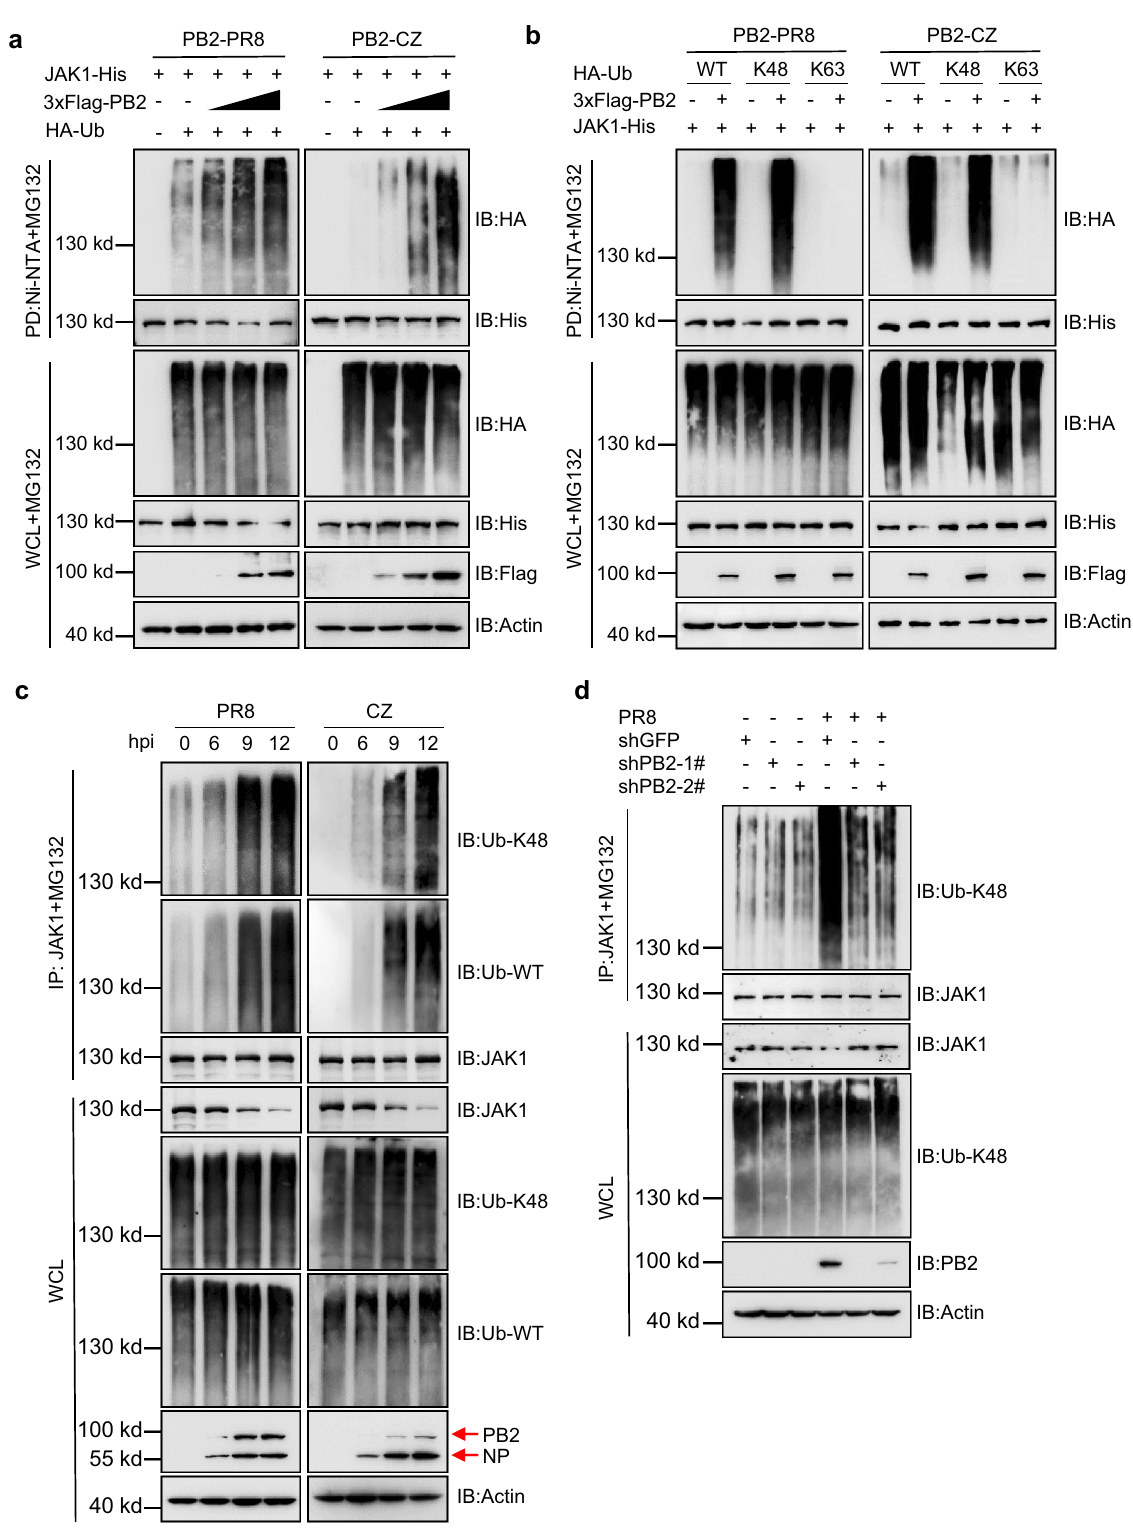
Fig. 3 | IAV PB2 protein increases the K48-linked ubiquitination of JAK1. a Ni- NTA pull-down analysis of the ubiquitination of JAK1 in HEK293T cells transfected with JAK1-His, HA-ubiquitin (HA-Ub), and PB2 plasmids and treated with MG132. b Ni-NTA pull-down analysis of the ubiquitination of JAK1 in HEK293T cells trans- fectedwithJAK1-His,HA-Ub,oritsmutantsK48andK63[Katindicatedresidue,and